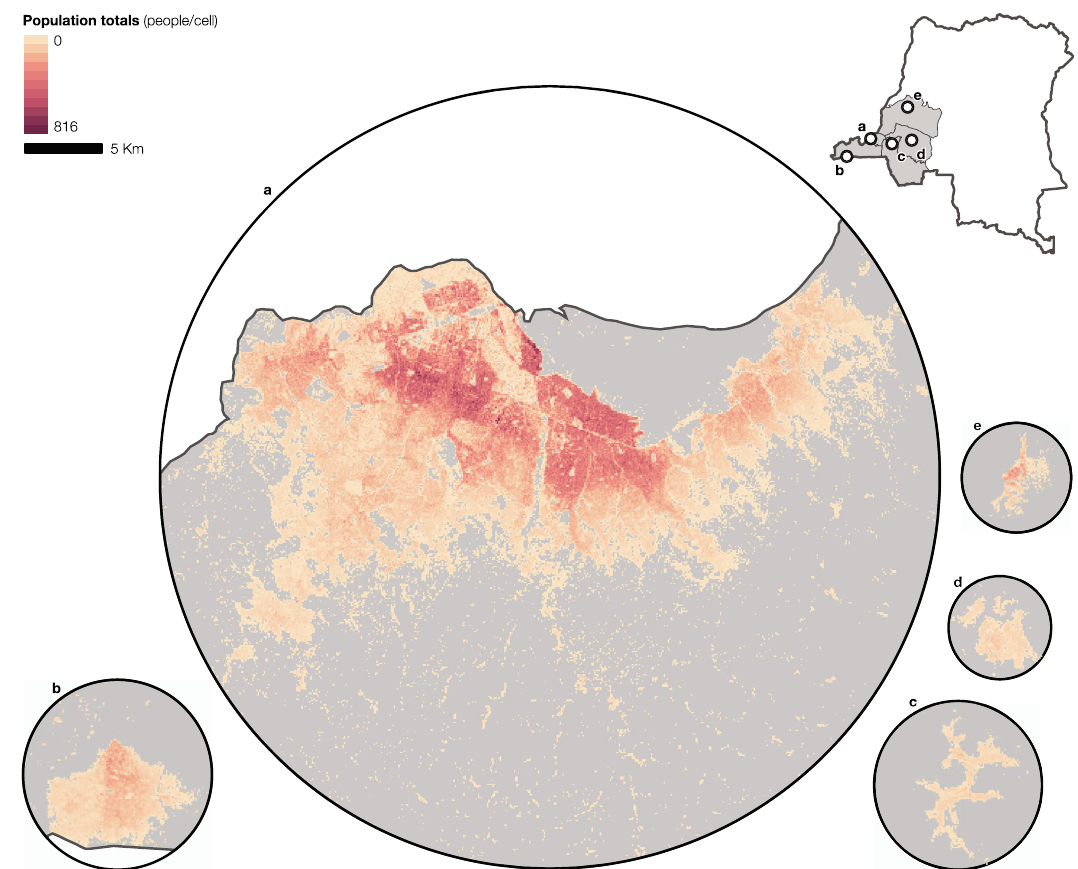
Fig. 1 Gridded population estimates in selected cities. Estimated population totals (people/cell) in the capital cities of the provinces of ( a ) Kinshasa (Kinshasa), ( b ) Kongo Central (Matadi), ( c ) Kwango (Kenge), ( d ) Kwilu (Bandundu), and ( e ) Mai-Ndombe (Inongo). The estimates represent the mean of the posterior distribution ( n = 10,000). The map of the DRC shows the extent of the fi ve provinces de fi ning the study region in